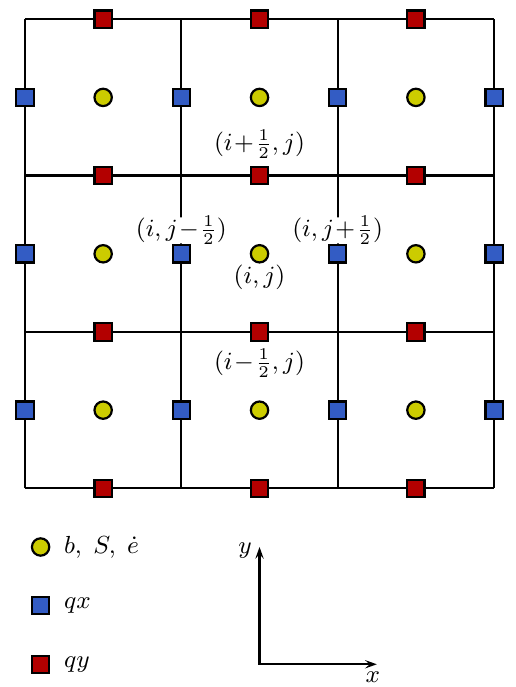
Figure 2. The periglacial landscape evolution model applies a stag- gered grid in which bed elevation, b , sediment thickness, S , and weathering rate, ˙ e , are stored in cell midpoints. The horizontal sed- iment flux components, q x s and q y s , are computed at cell